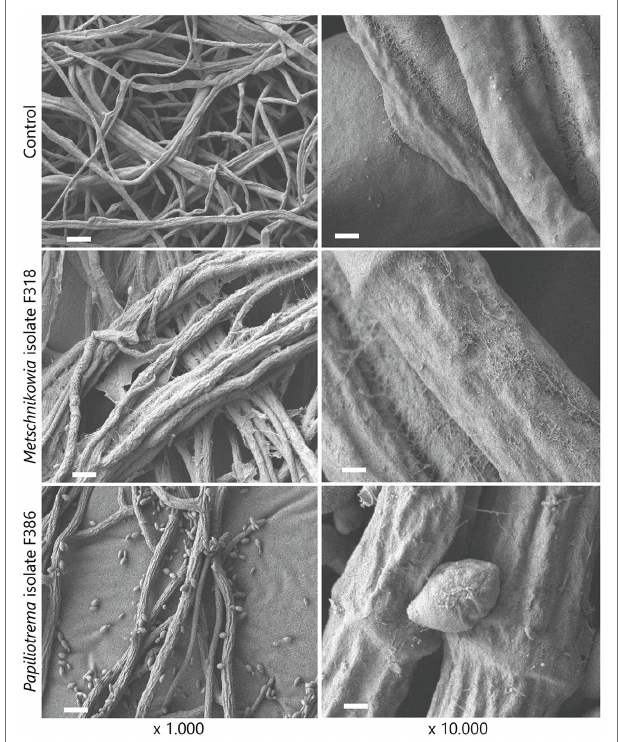
FIGURE 5 | Scanning electron microscopic (SEM) images of the interactions between phyllosphere yeasts and the fungal pathogen F. graminearum . Dual culture assays of F. graminearum growing alone (top panels) and exposed to Metschnikowia (middle panels) and Papiliotrema (bottom panels) isolates. Bars represent 10 μ m and 1 μ m for ×1.000 and ×10.000 magnification images, respectively.